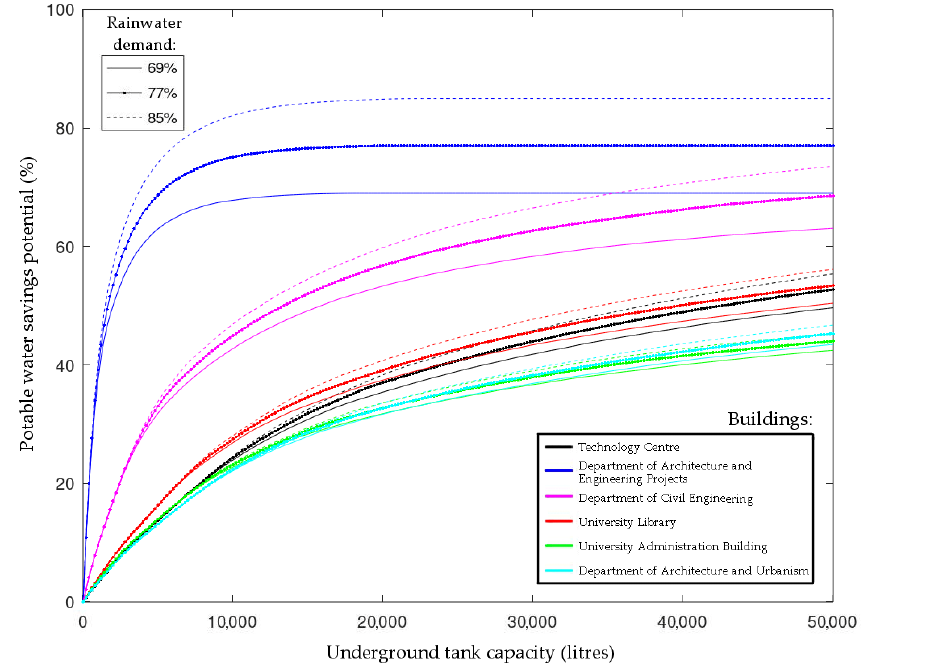
Figure 7. Potential for potable water savings for the six buildings located in Florianópolis.